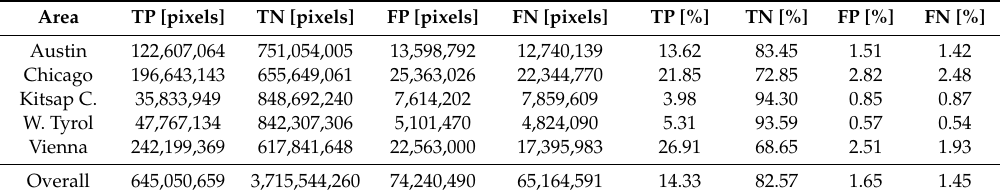
Table 4. Additional evaluation results using true positive (TP), true negative (TN), false positive (FP), and false negative (FN) metrics. Total number of pixels per area is 900,000,000, and overall,